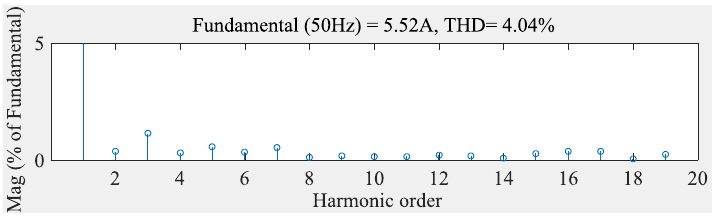
Figure 25. Harmonic spectrum of inductor current for the proposed